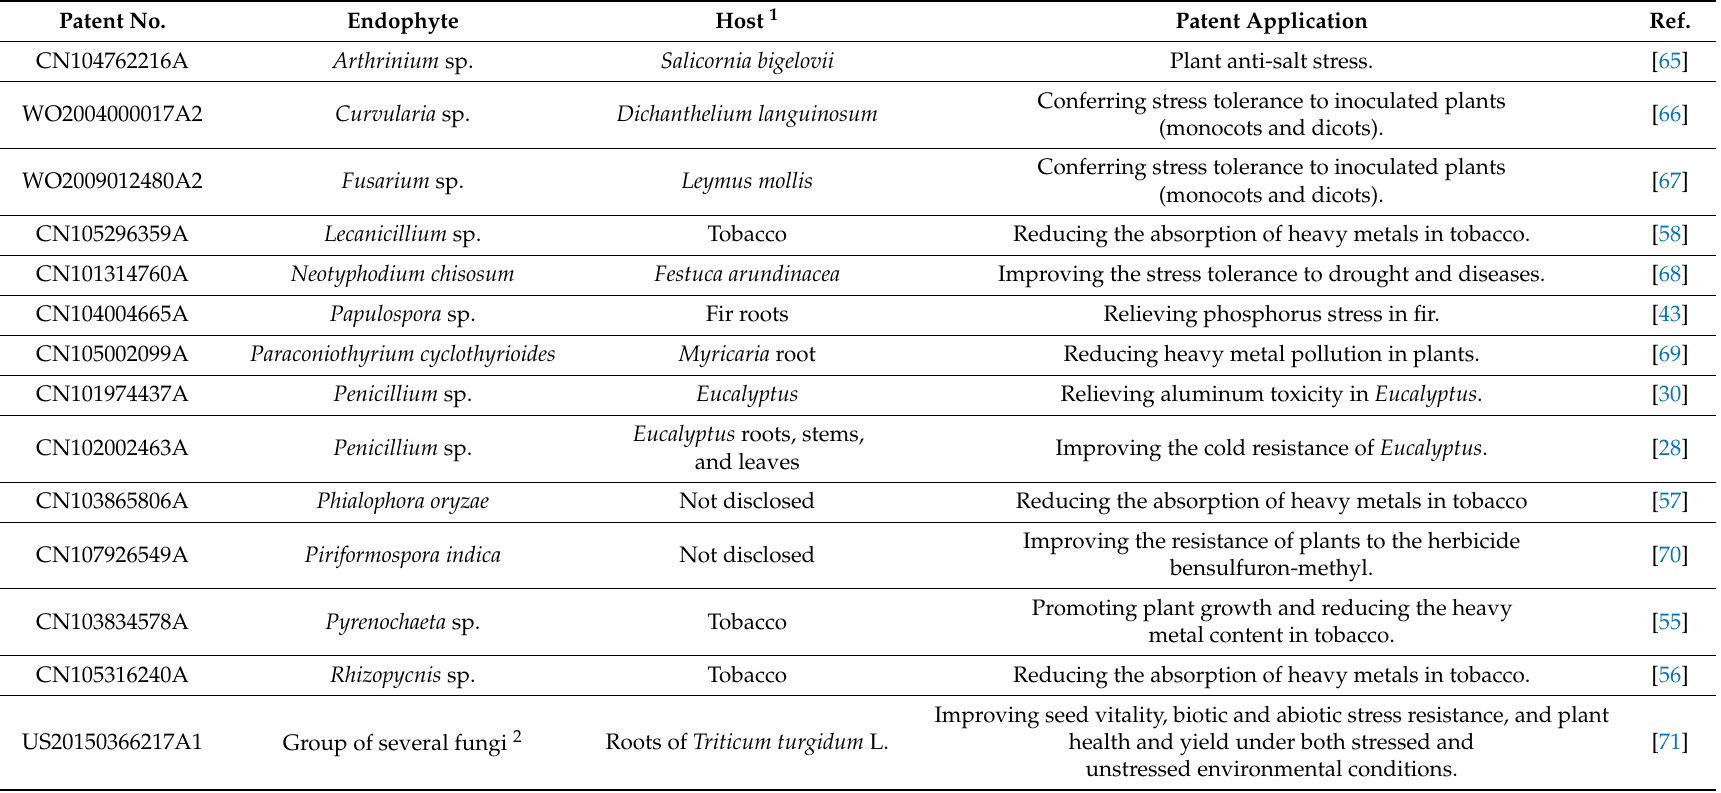
Table 1. Endophytic fungi applied to enhance the abiotic stress tolerance of